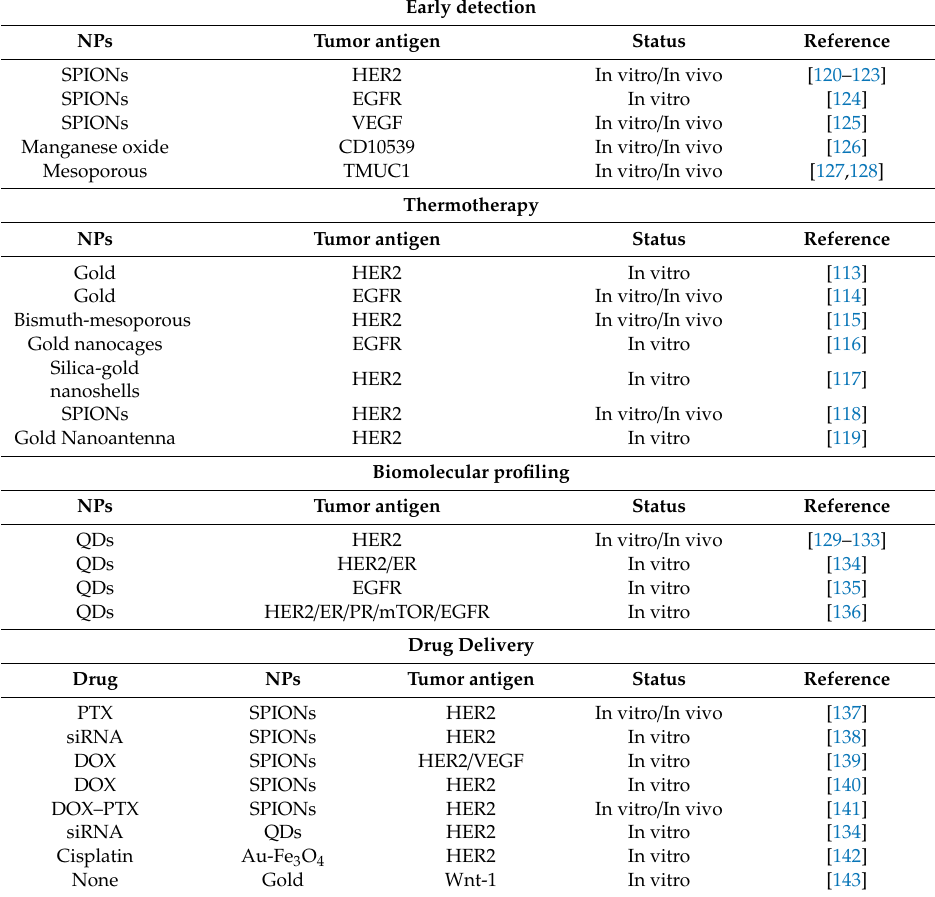
Table 2. InorganicACNPsforbreastcancerdiagnosisandtherapy. QDs: quantumdots, SPIONS:ironoxide superparamagnetic, VEGF: vascular endothelial growth factor, mTOR: mammalian target of rapamycin, ER: estrogen receptor, PR: progesterone receptor, Wnt-1: protein that in humans is encoded by the Wnt1 gene, CD: cluster of differentiation, TMUC1: polymorphic epithelial